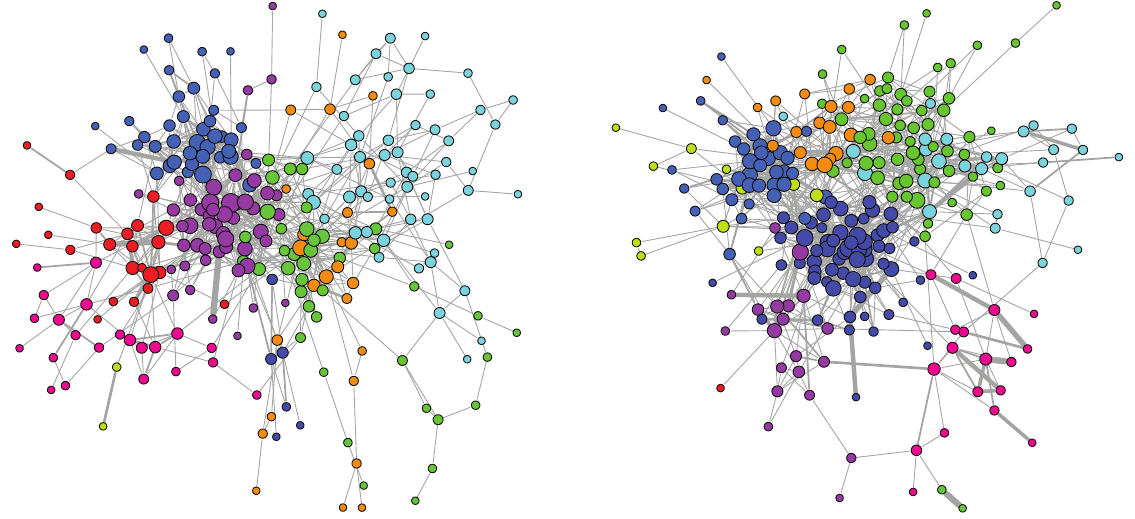
Figure 6. Communities in the largest connected components of firms projection in 2005 (Left) and 2010 (Right). The size of a node is proportional to the square root of its number of connections, the thickness of an edge is proportional to the number of shared directors between the connecting boards. Colors refer to the best-found community partition, whose weighted modularity score is 0 : 5976 for 2005 and 0 : 5895 for 2010.